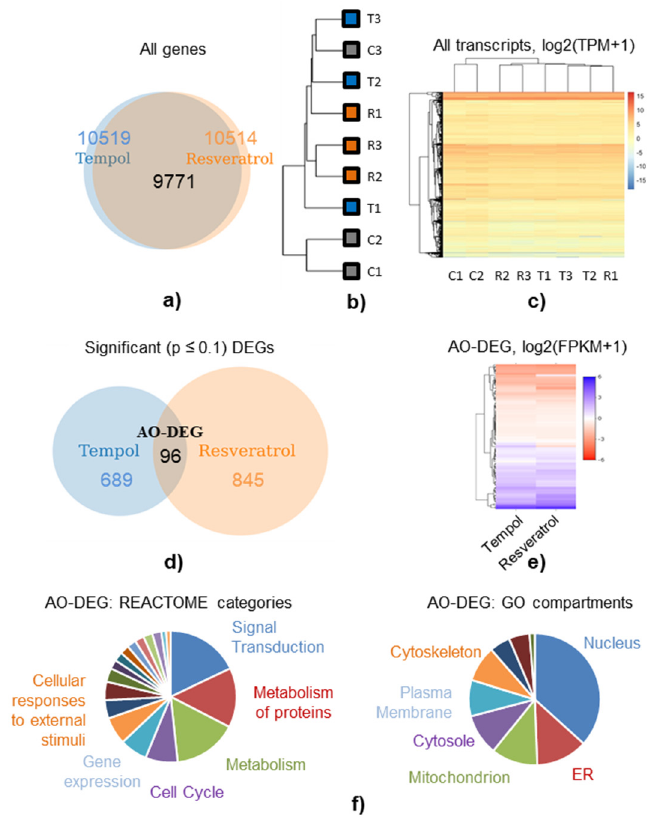
Figure 2. Transcriptomic analysis of the AO-stressed MSCs: differentially expressed genes; ( a ) genes identified with a nonzero expression in AO-stressed cells; ( b , c ) hierarchical clustering based on the log2(FPKM+1) of each gene ( b ) and on the log2(TPM+1) of each transcript ( c ); C, control RNA samples; T, RNA from Tempol-treated cells; R, RNA from resveratrol-treated cells; ( d ) significantly ( p -value ≤ 0.1, Bonferroni correction) altered genes identified after AO treatments; intersection depicts AO-DEG set of genes (see also Table S1); ( e ) hierarchical clustering based on the log2(FPKM+1) of each gene from the AO-DEG list; ( f ) diagrams showing pathway core categories (REACTOME) and cellular compartments (GO) to which the genes from the AO-DEG list belong. Abbreviations: differentially expressed genes (DEGs); set of significant ( p -value ≤ 0.1, Bonferroni correction) DEGs shared among both AO groups (AO-DEG); endoplasmic reticulum (ER); Fragments Per Kilobase Million (FPKM); Transcripts Per Kilobase Million (TPM); human mesenchymal stem cells (MSCs), line#2804.